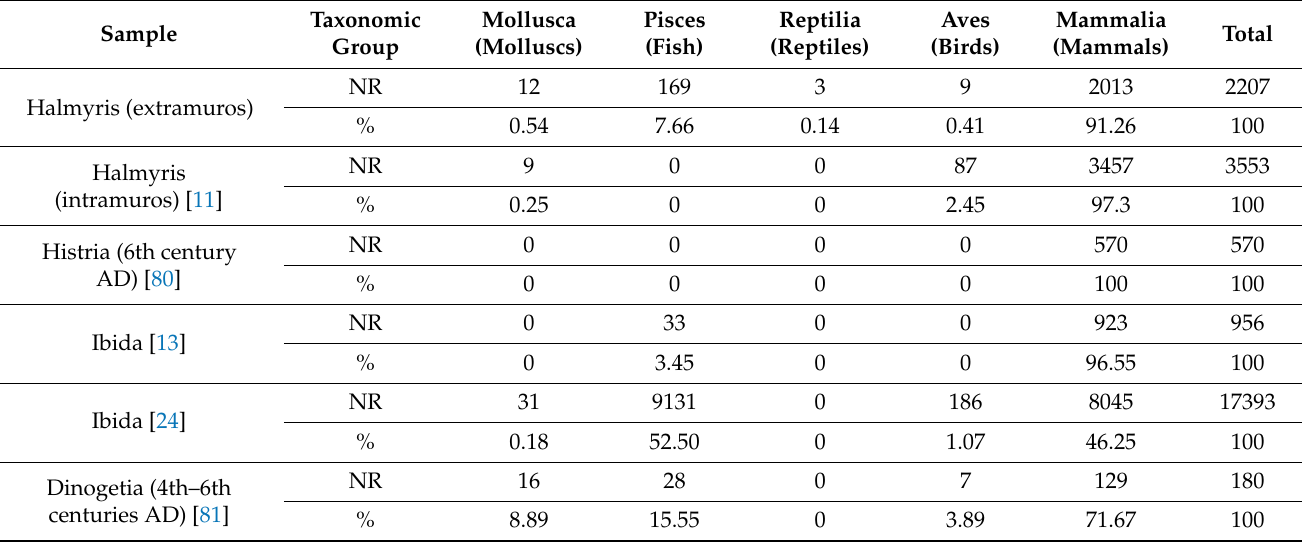
Table 7. Distribution of animal remains by taxonomic groups in faunal comparative samples (NR = number of